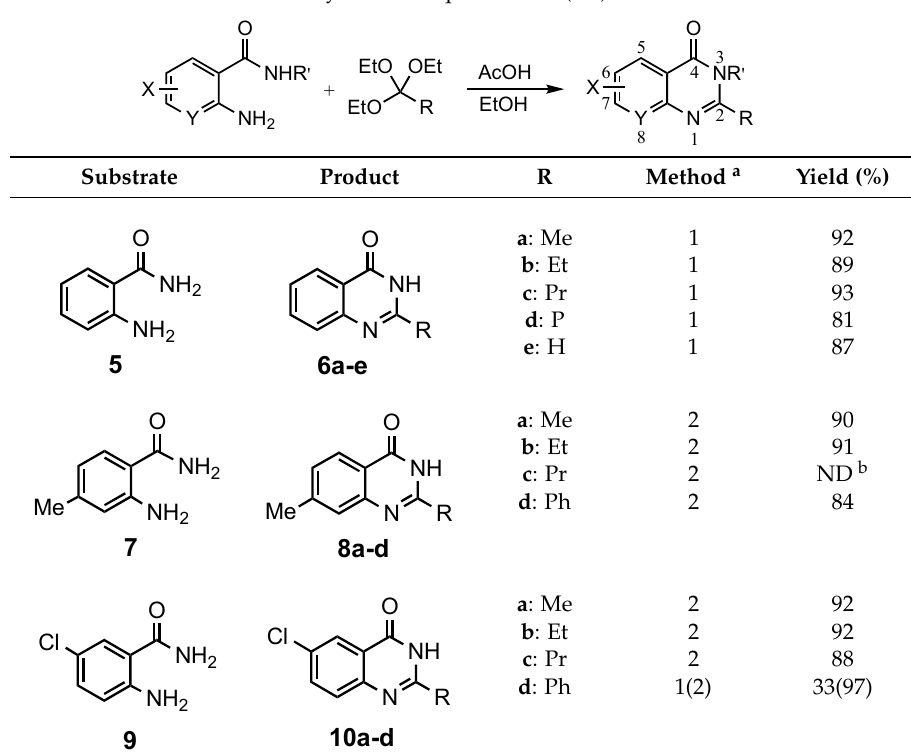
Table 1. Synthesis of quinazolin-4(3 H )-ones.